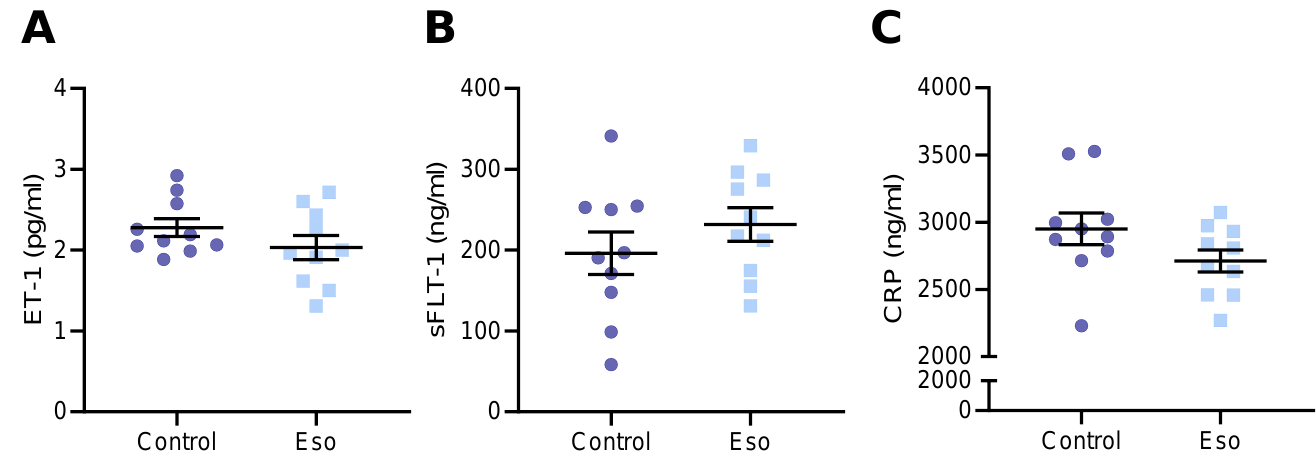
Figure 3. Effect of administration of esomeprazole in lean (normal weight) mice receiving L-NAME on circulating ET-1, sFlt-1, and CRP. Levels of ( A ) ET-1, ( B ) sFlt-1, and ( C ) CRP (measured via ELISA) were not reduced in the serum of mice receiving L-NAME plus esomeprazole in pregnancy, compared to that of the control mice (no esomeprazole). Data presented as mean ± SEM. n = 10 mice/group.